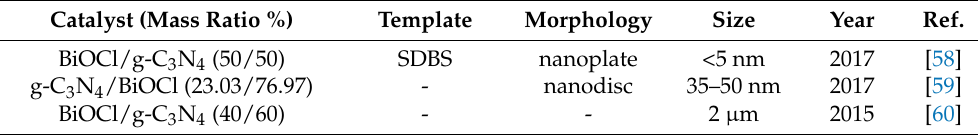
Table 1. G-C 3 N 4 /BiOCl heterojunctions synthesized by hydrothermal method. Catalyst (Mass Ratio %)